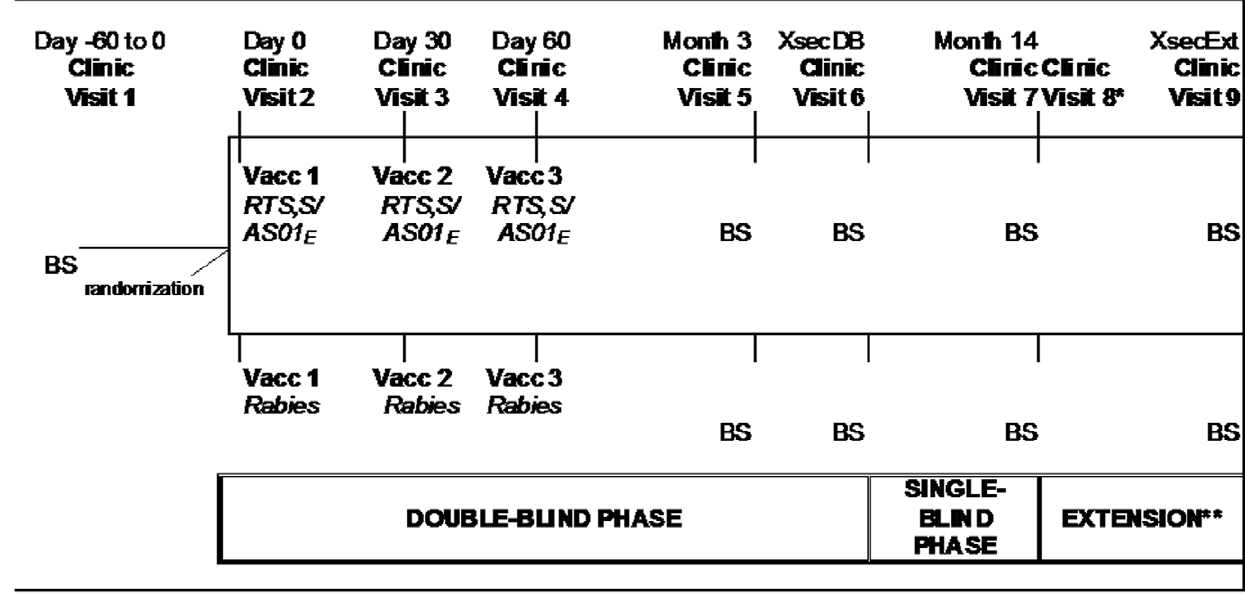
Figure 1. Study design overview. BS; Blood Sample, Vacc; Vaccination, Extension; Extension of the single-blind Phase. XsecDB : cross sectional at the end of double-blind Phase (; mean follow-up: 10 months, range: min 7.1; max 12.8 months post-dose 1; SD 1.3). XsecExt : cross sectional at the end of the extension Phase; mean follow-up: 18 months (range: min 13.8; max 20.1 months post-dose 1; SD 1.5). *Clinic Visit 8 took place on the same day as clinic Visit 7 and included consent process for participation in the extension Phase (Kilifi only). **Applicable to Kilifi only.